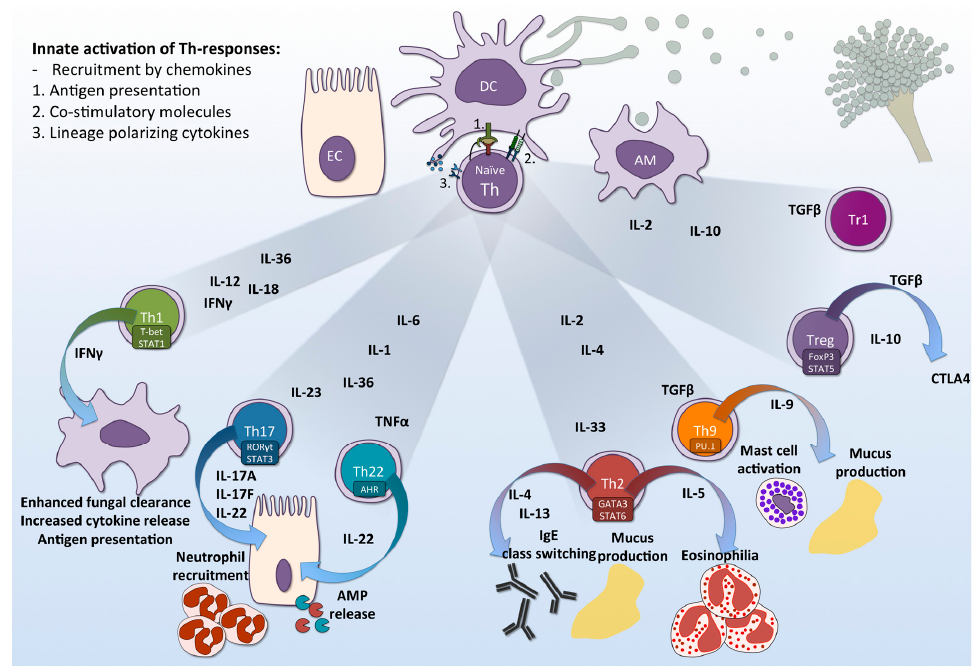
Figure 1. T-helper responses to A. fumigatus. The epithelial cell (EC), dendritic cell (DC) and alveolar macrophage (AM) constitute the innate immune response against A. fumigatus . Engagement of surface pattern recognition receptors (PRRs) on these cells triggers downstream signaling pathway, leading to production of distinct lineage-polarizing cytokines. This, in combination with antigen presentation by via MHC-II and binding of co-stimulatory molecules, in turn lead to activation and differentiation of naïve CD4 + T-helper cells to distinct effector lineages: Th1, Th17, Th22, Th2, Th9, Treg and Tr1. These effector cells differentially contribute to either protection against fungal infection, detrimental immunopathology, or in the regulation of the adaptive immune response. EC = Epithelial cell; DC = Dendritic cells; AM = Alveolar macrophages; Th = T-helper cells; IL = Interleukin; IFN = Interferon; TGF = Transforming growth factor; TNF = Tumor necrosis factor; AMP= antimicrobial peptide; CTLA-4 = cytotoxic T-lymphocyte antigen 4; STAT = Signal Transducer and Activator of Transcription, ROR γ t = RAR-related orphan receptor gamma t; AHR = aryl hydrocarbon receptor; t-Bet = T-box transcription factor 21; GATA3 = Transcription factor GATA-3; PU.1 = Transcription factor PU.1; FOXP3 = Forkhead box P3.